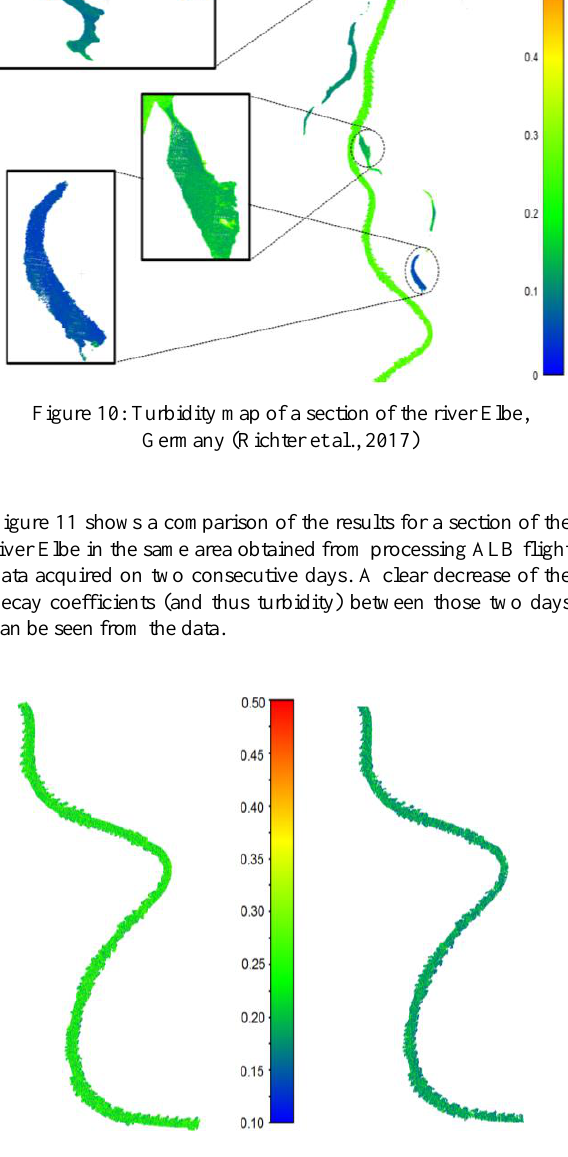
Figure 9: Study area at the river Elbe, Germany (Richter et al., Figure 11: Turbidity map of a section of the river Elbe at two 2017) consecutive days (Richter et al.,